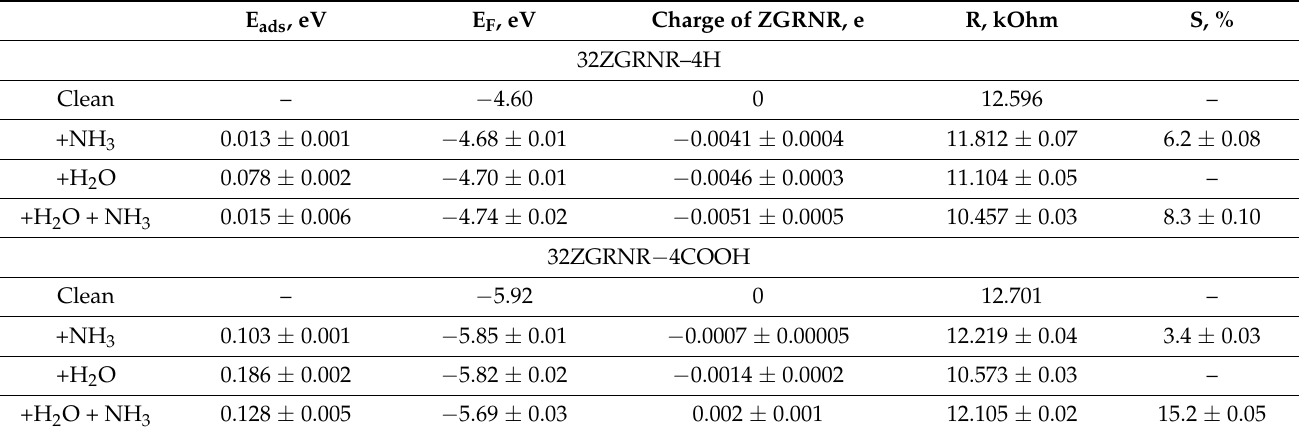
Table 2. Energy characteristics of non-functionalized zigzag 32ZGRNR–4H nanoribbon and carboxylated 32ZGRNR– 4COOH